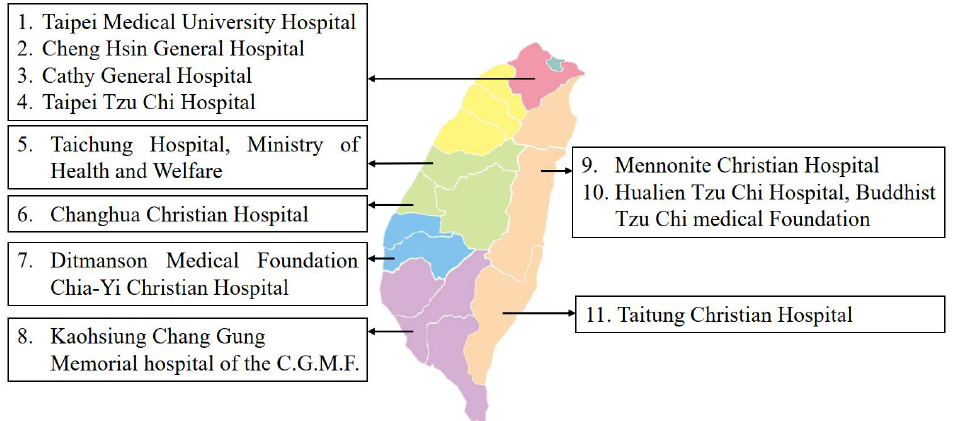
Figure 1. The distribution of eleven selected hospitals across Taiwan.